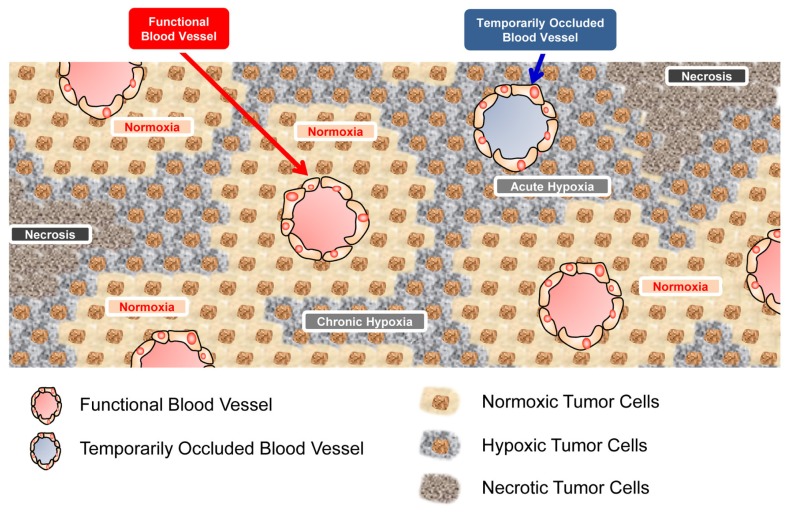
Schematic diagram of micro tumor cords. Because of the limited distance that molecular oxygen can diffuse from functional blood vessels, cancer cells can obtain oxygen only in close proximity to functional vessels (normoxic regions). Cancer cells approximately 70–100 μm from blood vessels cannot obtain oxygen (hypoxic regions). Cancer cells even farther away become necrotic. Because blood vessels in malignant solid tumors are immature and highly tortuous, they are sometimes occluded temporarily. Then, cancer cells surrounding dysfunctional vessels are known to be exposed to acute hypoxia.